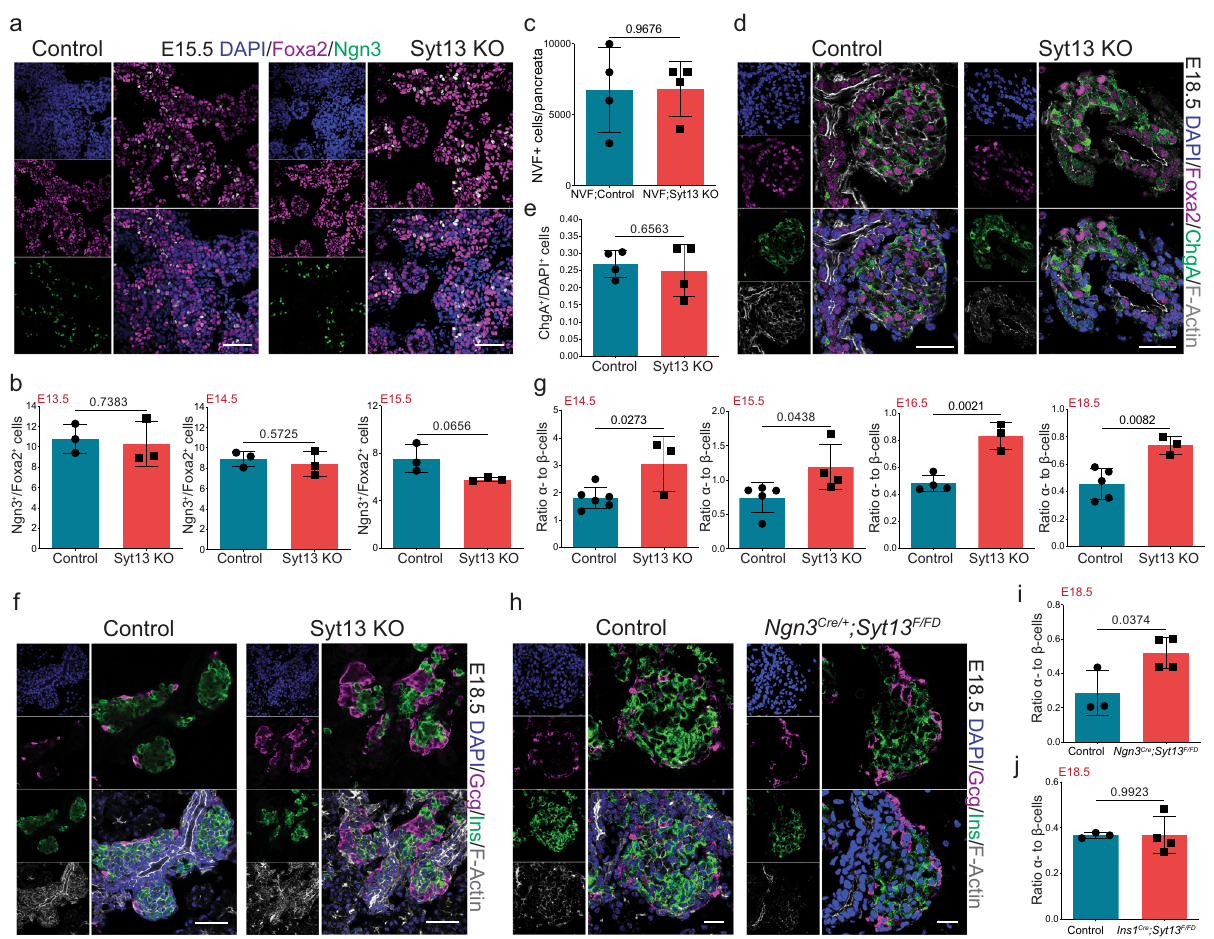
Fig. 3 Loss of Syt13 reduces β -cell speci fi cation. a IHC analysis showing Ngn3 + cells in control and Syt13 KO mice. b Quanti fi cation of the percentage of Ngn3 + cells. n = 3 independent pancreata for a and b . c Total number of NVF (Ngn3 + ) cells in E15.5 pancreata sorted by FACS. n = 4 independent pancreata. d IHC analysis of ChgA in pancreatic sections. e Quanti fi cation of ChgA + cells in E18.5 pancreata. n = 4 independent pancreata for d and e . f IHC analysis of pancreaticsectionsfromcontrol and Syt13 KOmice. g Quanti fi cation ofthe α / β cells ratio inpancreaticsectionsfromcontroland Syt13 KOmice. n = 6 controls and 3 KO (E14.5), 5 controls and 4 KO (E15.5), 4 controls and 3 KO (E16.5), and 5 controls and 3 KO (E18.5) independent pancreata for f and g . h IHC analysis of pancreatic sections from control and Ngn3 Cre/ + ;Syt13 F/FD mice. ( i , j ) Quanti fi cation of the α / β cells ratio in Ngn3 Cre/ + ;Syt13 F/FD , and Ins1 Cre/ + ;Syt13 F/FD pancreata, respectively. n = 3 controls and 4 KO (E18.5) independent pancreata for h – j . Scale bar 50 µ m ( a , d , f ); 20 µ m ( h ). All statistics have been done using two-sided t -test. Data are represented as mean±SD. Source data are provided as a Source Data fi The intracellular traf fi cking of Syt13 requires microtubules . To identify the molecular components linked to Syt13 functions during endocrine cell egression, we performed pathway enrich- ment analysis of differentially expressed genes between Syt13 high and Syt13 low/ − endocrine precursors. We found that increased Syt13 expression in these cells was linked to differential expres- sion of genes coding for microtubule (MT) cytoskeletal compo- nents and regulators as well as intracellular transport pathways (Fig. 5a and Supplementary Data 2). Among them, the transcript levels of Tuba1a , Tuba4a , and Tubb3 increased during endocri- nogenesis, while the levels of genes encoding other tubulin iso- types decreased or remained unchanged (Fig. 5b). Notably, mRNA levels of Tuba1a , Tuba4a , and Tubb3 were higher expressed in Syt13 high than in Syt13 low/ − precursors (Fig. S8a). Furthermore, we found increased protein levels of α -tubulin and β 3-tubulin in endocrine cells and Syt13-expressing cells (Fig. 5c – f, Fig. S8b, c). α -tubulin is synthesized with a tyrosine residue at the C-terminus (Tyr-tub) and can be post-translationally mod-